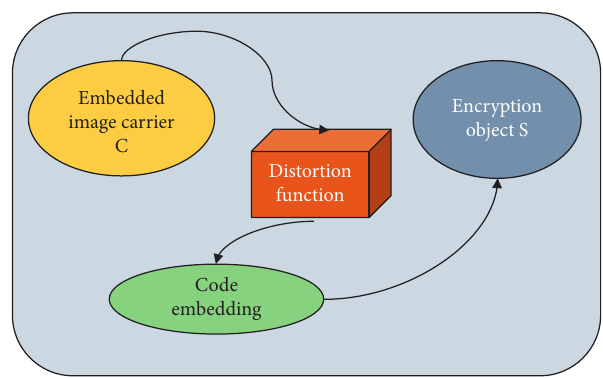
Figure 4: Basic framework of adaptive steganography image en- hancement algorithm for the spatial